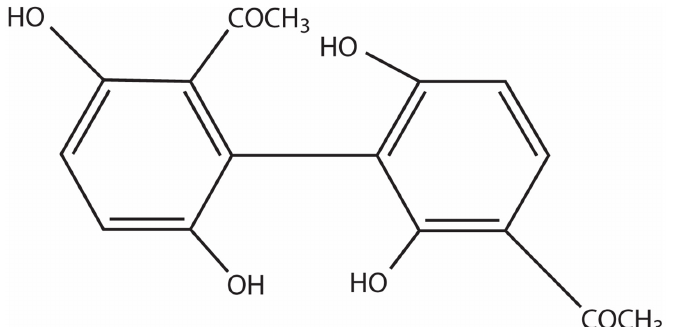
Fig 1. The chemical structure of